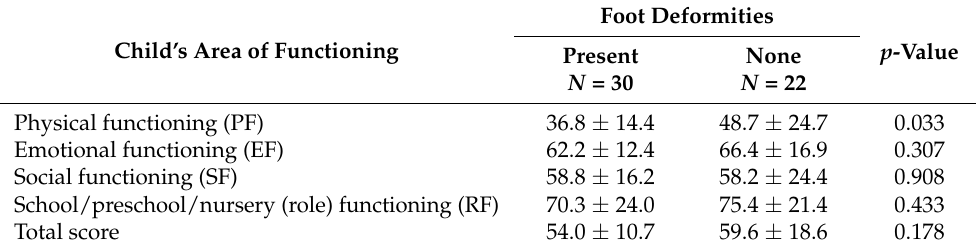
Table 8. Basic statistics (M ± SD) for children’s functioning scores, broken down by the presence or absence of foot deformities, with the significance of the test